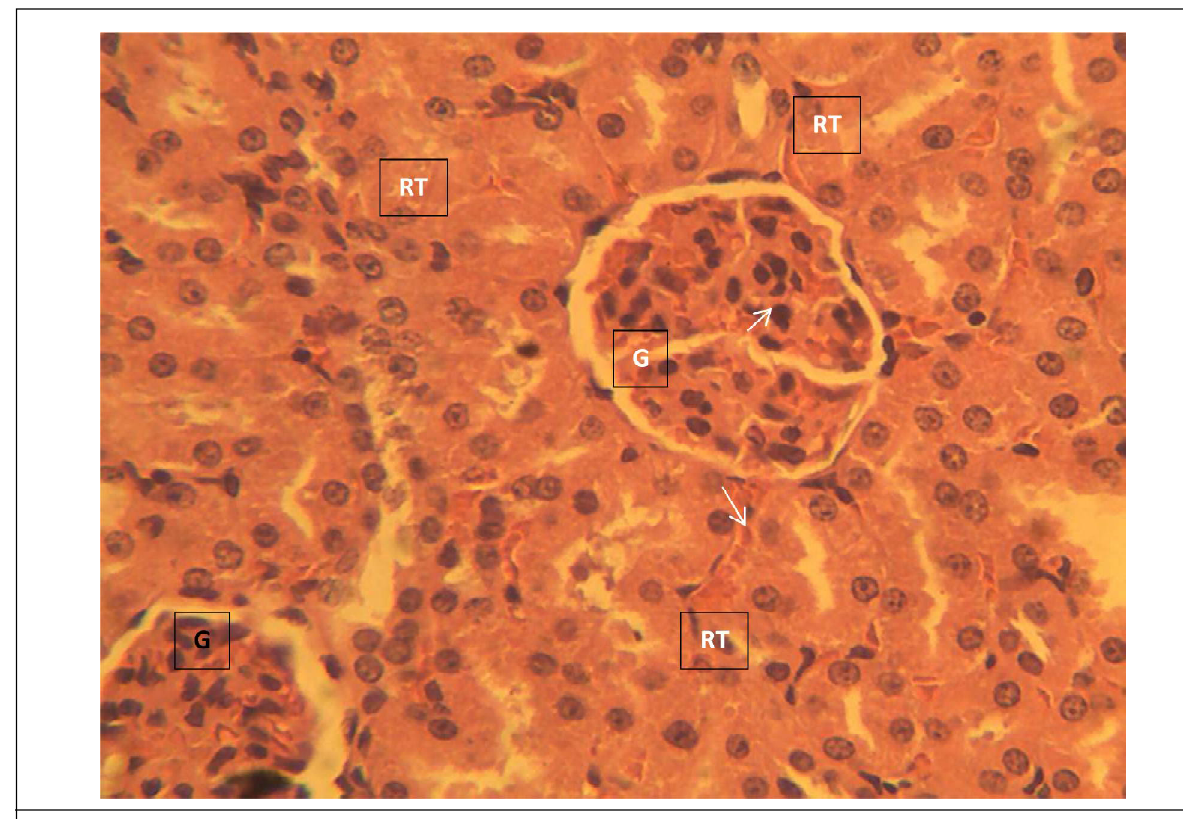
Plate 18: Female kidney of the group exposed to 800 mg/kg of aqueous extract